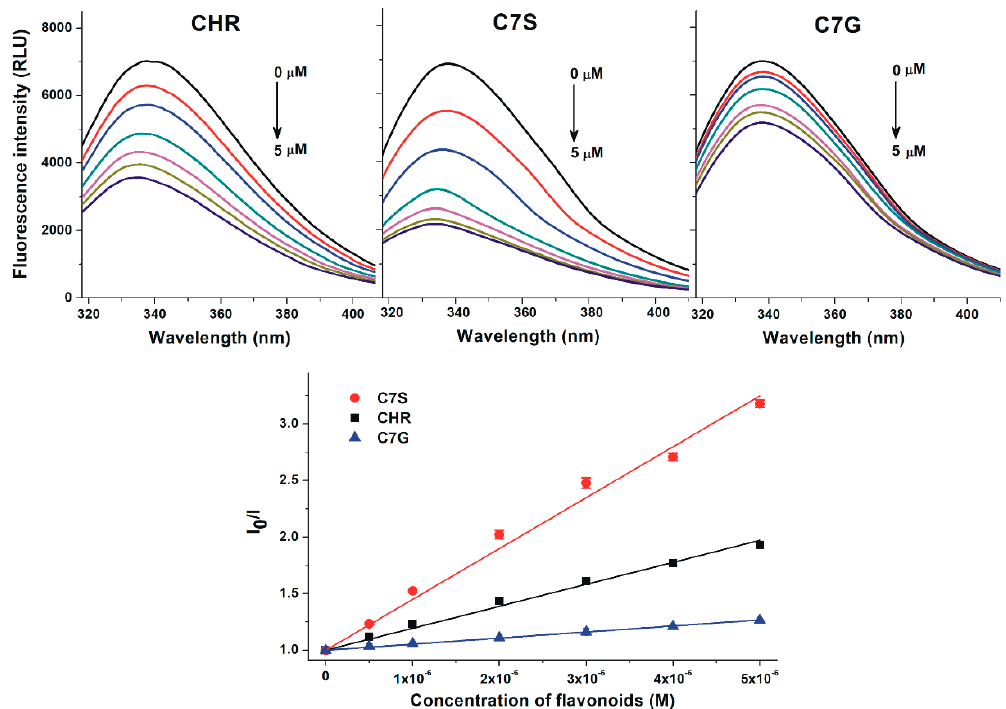
Figure 2. Top graphs: Fluorescence quenching effects of chrysin (CHR; left), chrysin-7-sulfate (C7S; middle), and chrysin-7-glucuronide (C7G; right) on HSA (2 µmol/L) in PBS (pH 7.4; λ ex = 295 nm, λ em = 340 nm). Bottom graph: Stern–Volmer plots of flavonoid–HSA complexes.